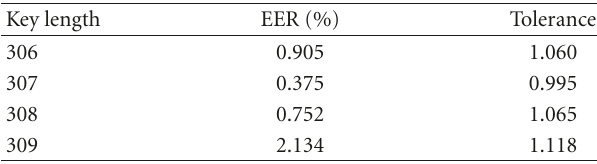
Table 1: Summary of experimental results.